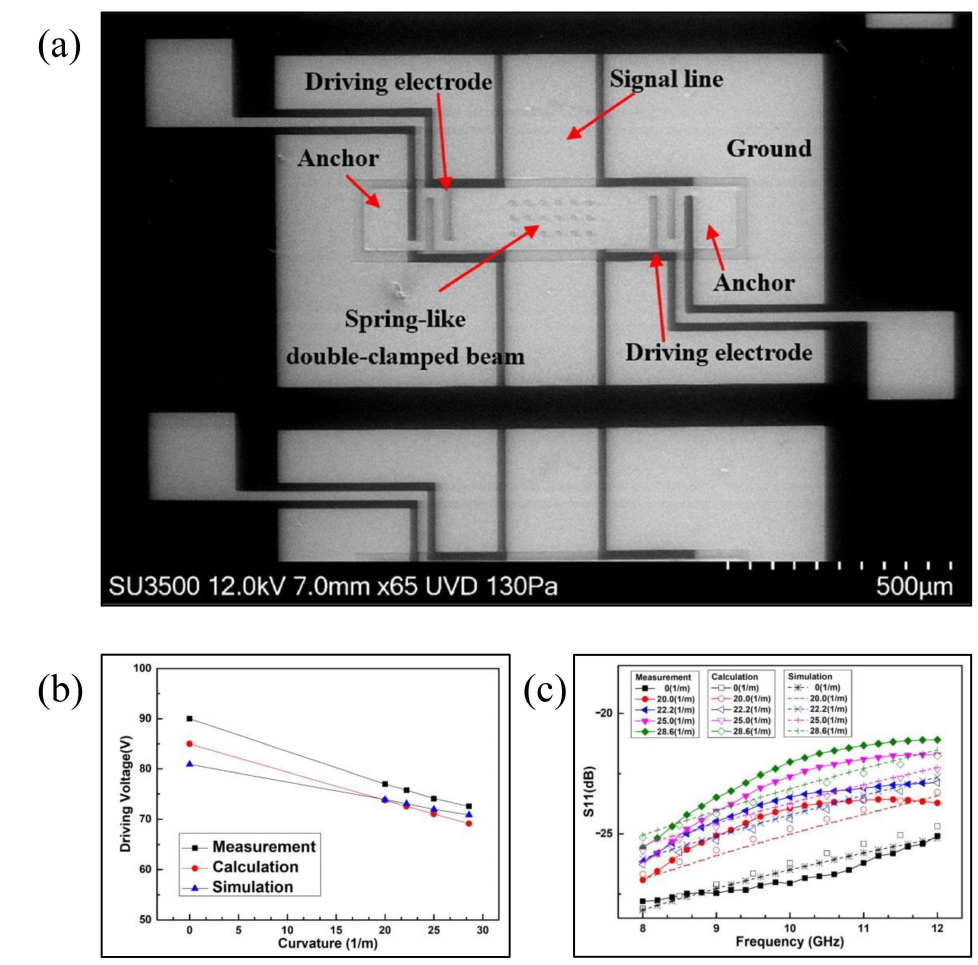
Figure 3. ( a ) Spring-like beam electrostatically actuated flexible RF MEMS switch [67]. ( b ) Measured driving time [67] and ( c ) reflection loss S11 [67] of the switch measured under different curvatures.